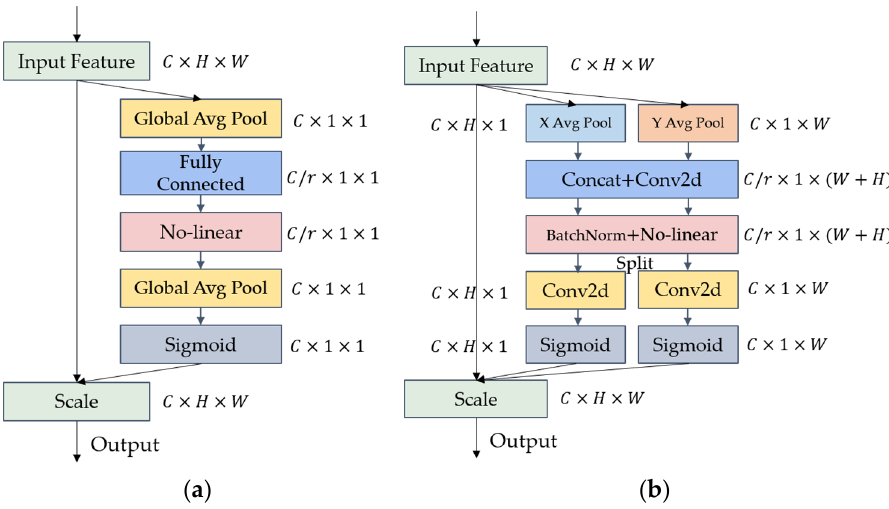
Figure 8. ( a ) SE Attention structure; and ( b ) Coordinate Attention structure.